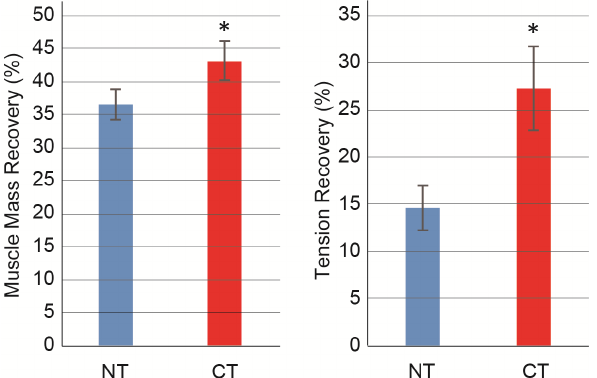
Figure 2. Recovery ratio of muscle mass and tetanic tension output. Values are expressed as mean percentages for the non ‐ operated contralateral side in each individual. Muscle mass and tetanic tension output were evaluated as total mass and tension output of planter flexor (plantaris + soleus + gastrocnemius) muscles. Muscle mass and tension recovery ratio was calculated as follows; (operated muscles mass/contralateral muscles mass) × 100, (tension output of operated muscles/tension output of contralateral muscles) × 100. NT, non ‐ cytokine administered control group; CT, cytokine administered group. Values are expressed as mean ± SE. * p < 0.05.